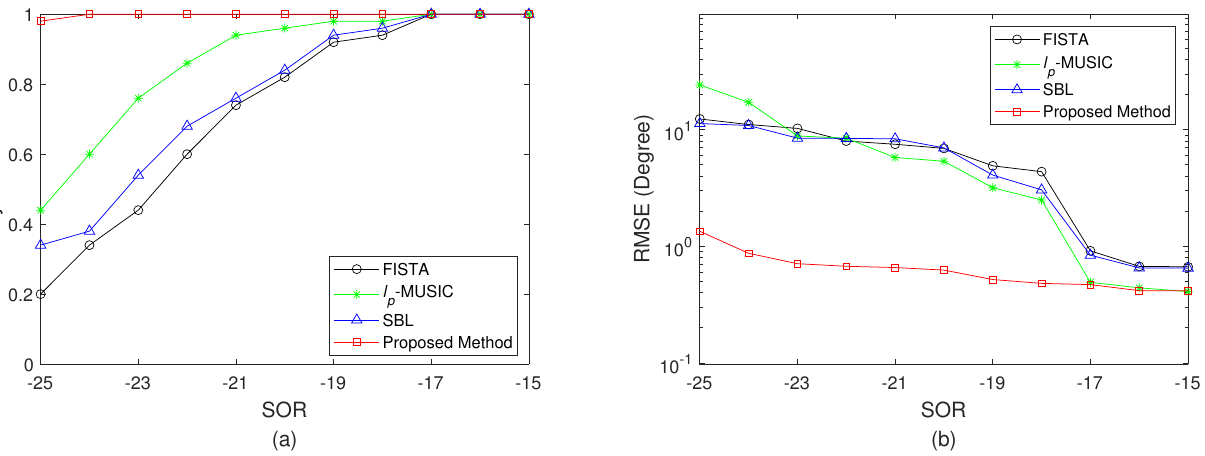
Figure 1. Performance comparison of the algorithms as a function of the SOR. ( a ) Probability of resolution. ( b ) RMSE.